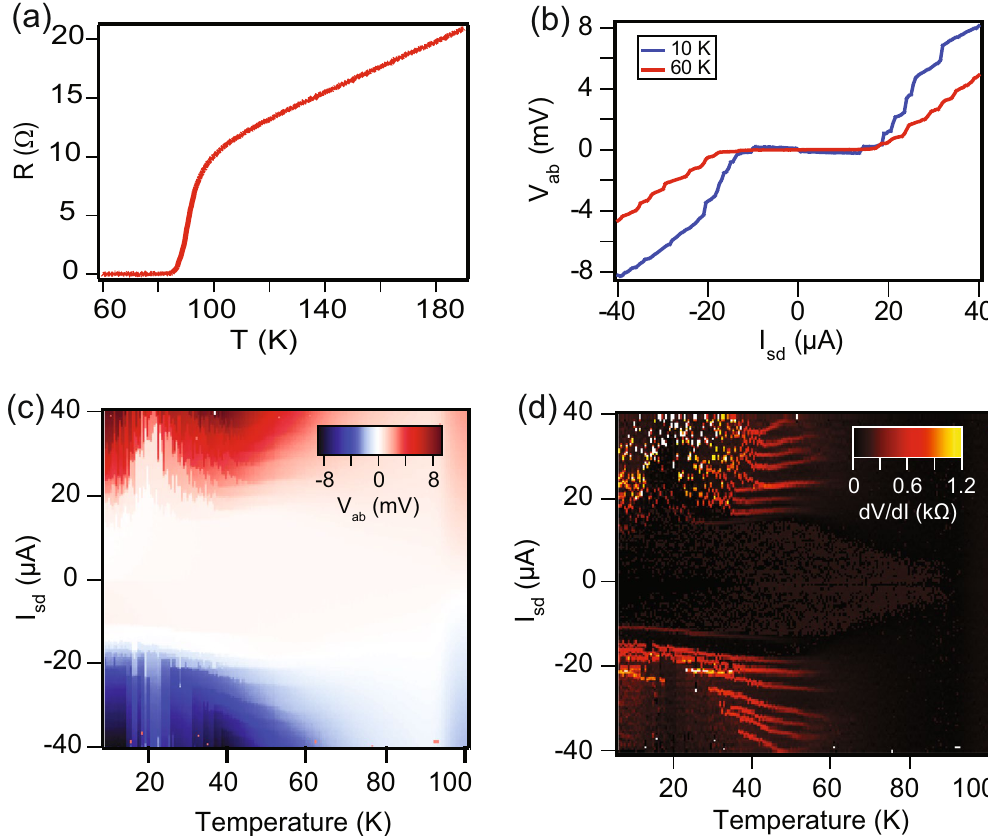
Figure 3. Temperature dependent transport properties, at 0 T, of exfoliated BSCCO flakes. ( a ) Four-probe R vs T plot for the device D2. ( b ) I–V characteristics at 10 K and 60 K for the device D1. A critical current of 13 μ A is observed. ( c ) I–V plotted for D1 as a color scale with temperature sweep from 10 K to 100 K. ( d ) Color scale plot of numerical derivative dV/dI from 10 K to 100 K for D1. A superconducting transition temperature (T c ) of 86 K is